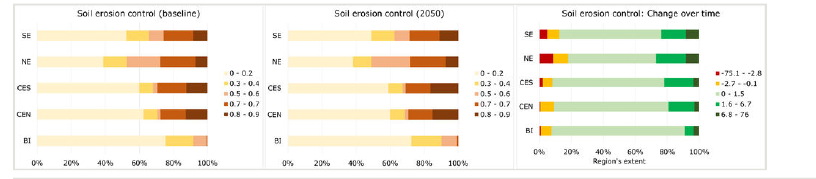
Figure 9. From left to right, soil erosion control for the baseline, the 2050 and as percent change over time. The scores are shown in relation to the percent extent of fi ve European regions, de fi ned after grouping the 28 Member States (MS) according to their climatic characteristics (Ciscar Martinez et al. 2011). The chart on the right shows the percent change over time in the predicted soil erosion control, for the same set of regions. In all charts, the y-axis shows the di ff erent regions (SE: South Europe; CEN: Central Europe North; CES: Central Europe South; NE: North Europe; BI: British Isles). See Suppl. material 3 for a grouping of MS within each region. See main text for additional details.